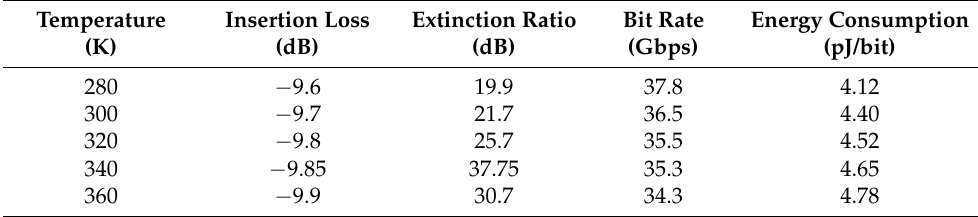
Table 1. The performance of CIPMRMs for different temperatures.